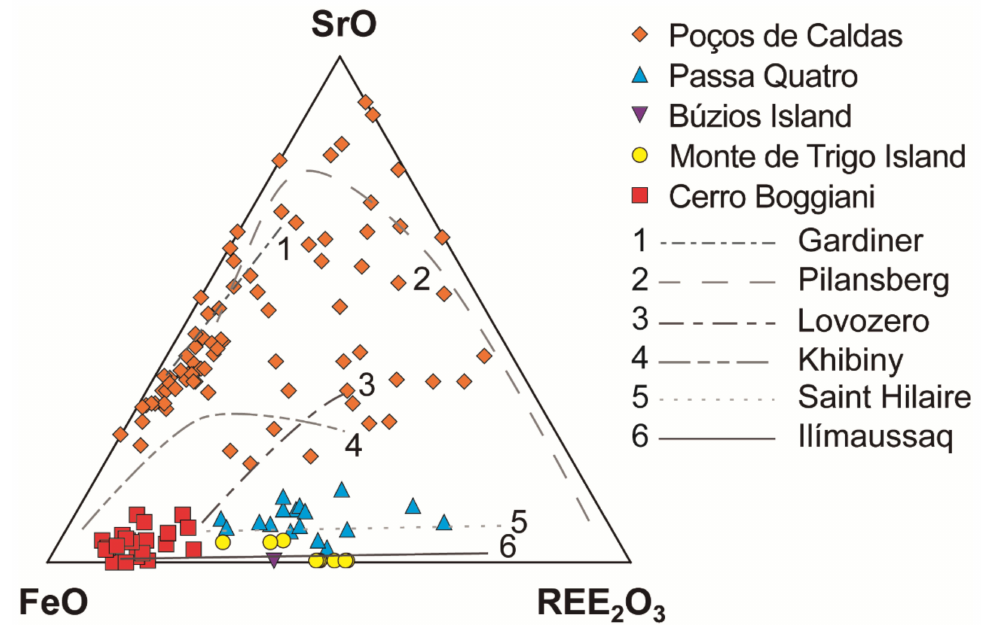
Figure 4. Ternary plot of FeO-SrO-REE 2 O 3 for the eudialyte-group minerals. Data sources: [14,20,26,34,65,72,81,82,92]. Trend lines of the worldwide EGM compositions according to [26] and references